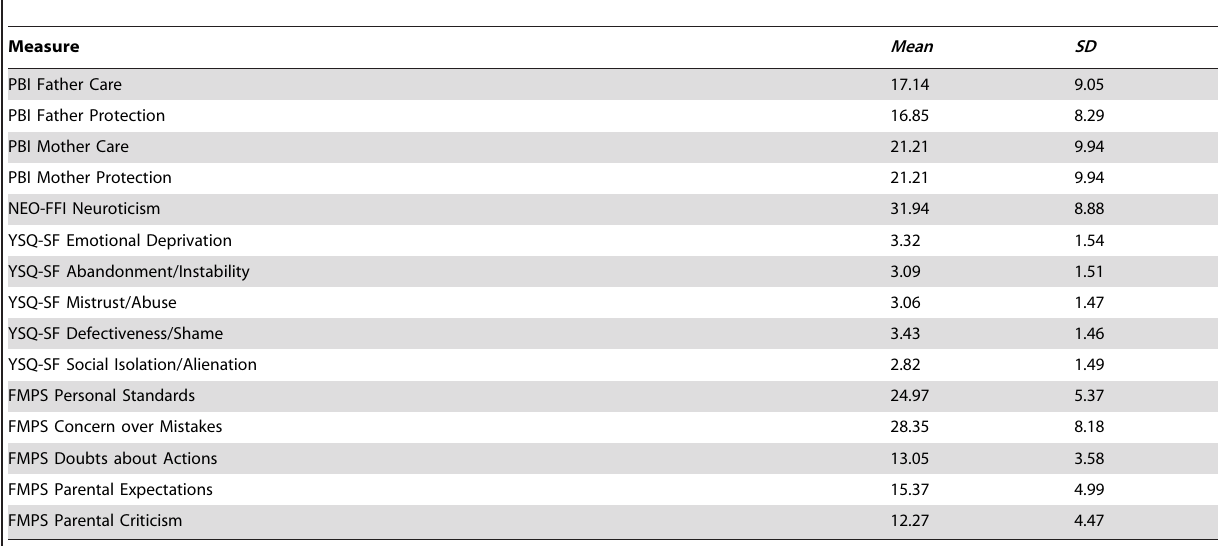
Table 2. Means and Standard Deviations for the Subscales of the PBI, NEO-FFI, YSQ-SF and FMPS.